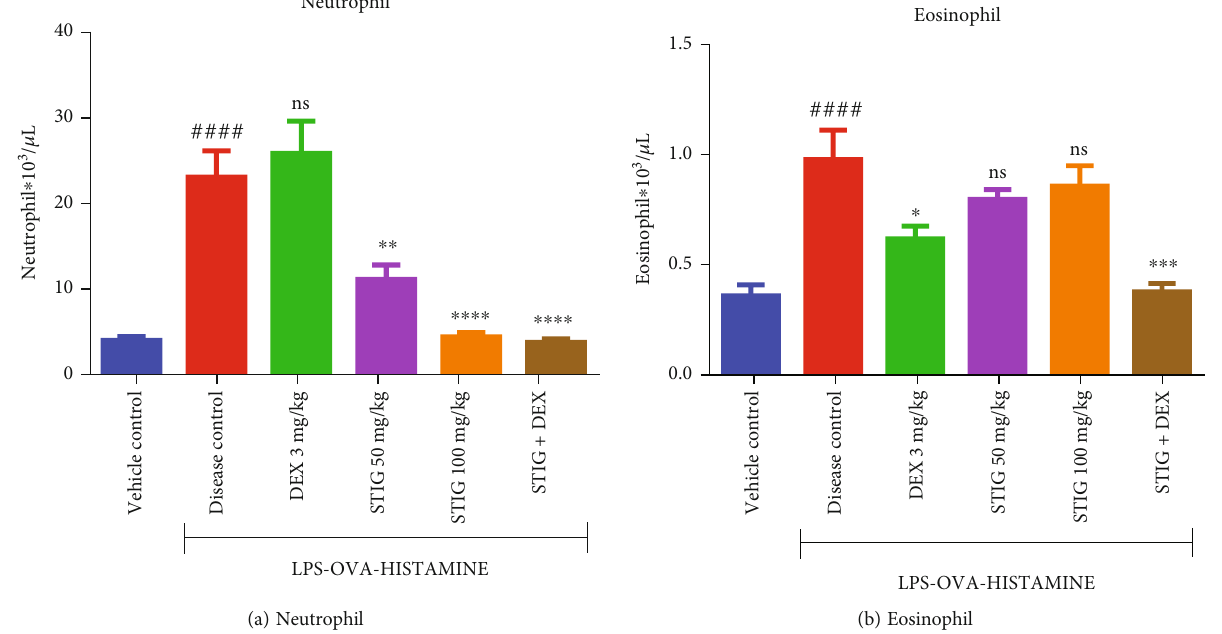
Figure 2: E ff ects of STIG and STIG+DEX on neutrophil and eosinophil levels. Data is expressed as mean ± SEM . #### p < 0 : 0001 compared to the vehicle control group; ∗∗∗∗ p < 0 : 0001 , ∗∗∗ p < 0 : 001 , ∗∗ p < 0 : 01 , ∗ p < 0 : 05 , and ns (not signi fi cant) as compared to the disease control group using one-way ANOVA followed by Dunnett ’ s post hoc